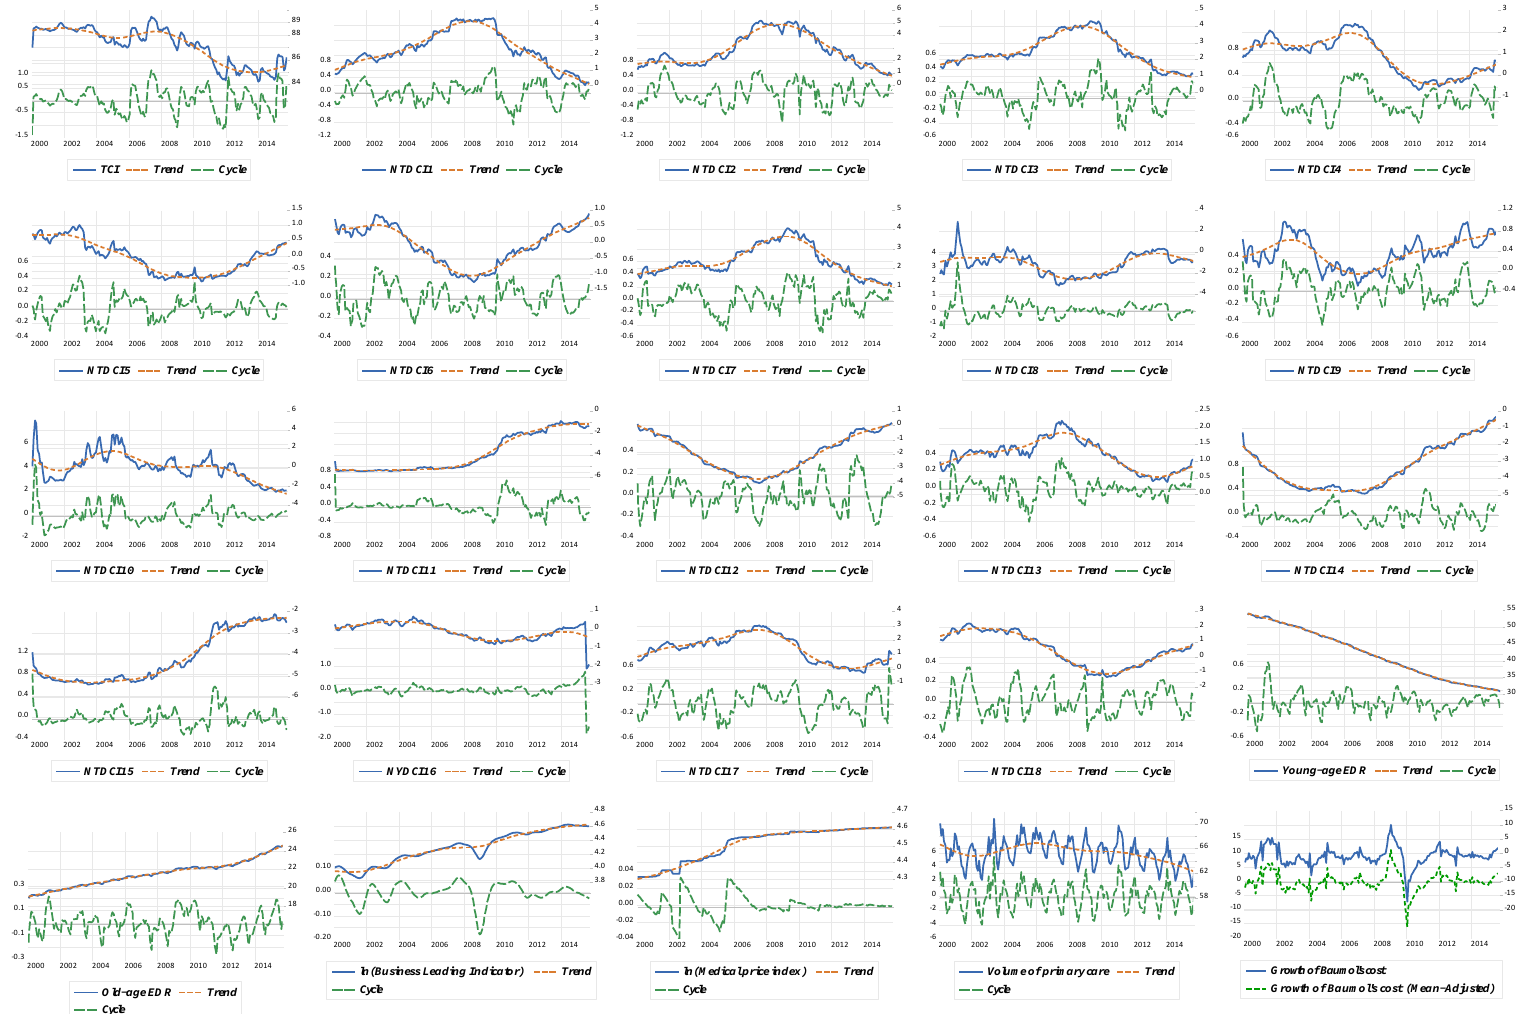
Figure 2. Time plots for variables used for the robust least square estimation. Note: TCI and NTDCI i ( i = 1, 2, . . . , 18) represent total connectedness and net total directional connectedness indices of CCS code i , respectively. The monthly indices were aggregated from weekly indices. ln( • ) is the nature logarithm operator. All trends were generated using the